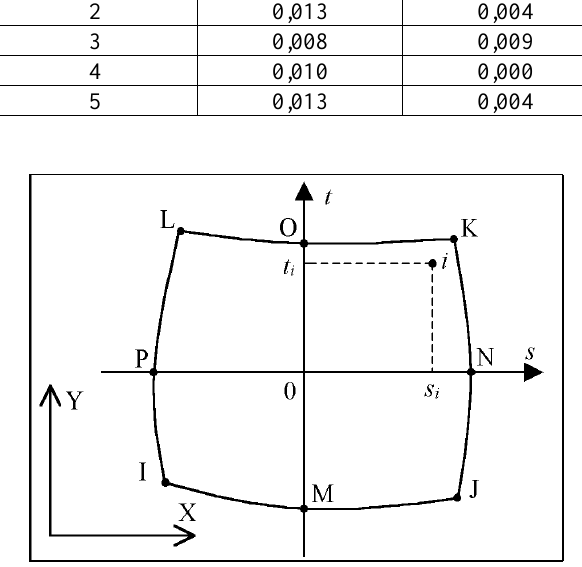
Table 2. Movements of